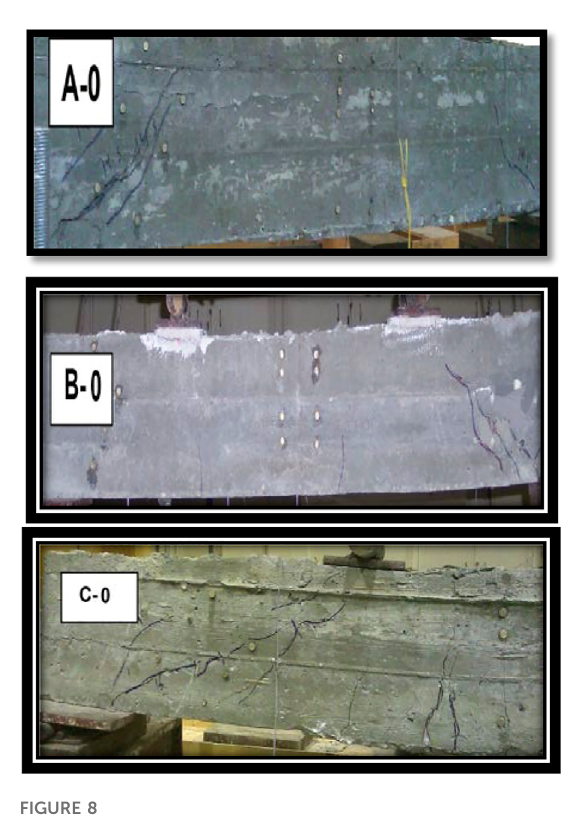
FIGURE 8 Propagation of cracks and modes of failure for HSRC specimens with varying a/d